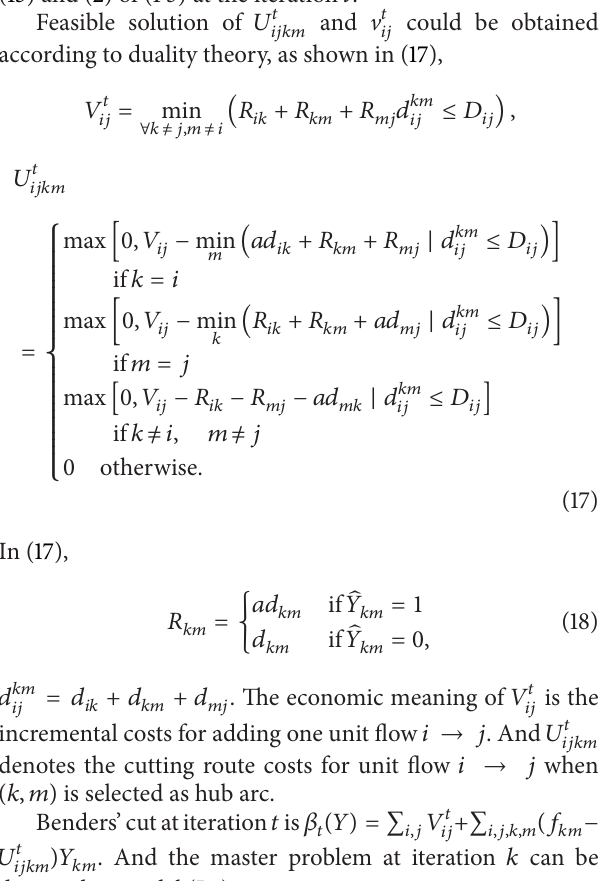
Algorithm 5 (Benders decomposition method for